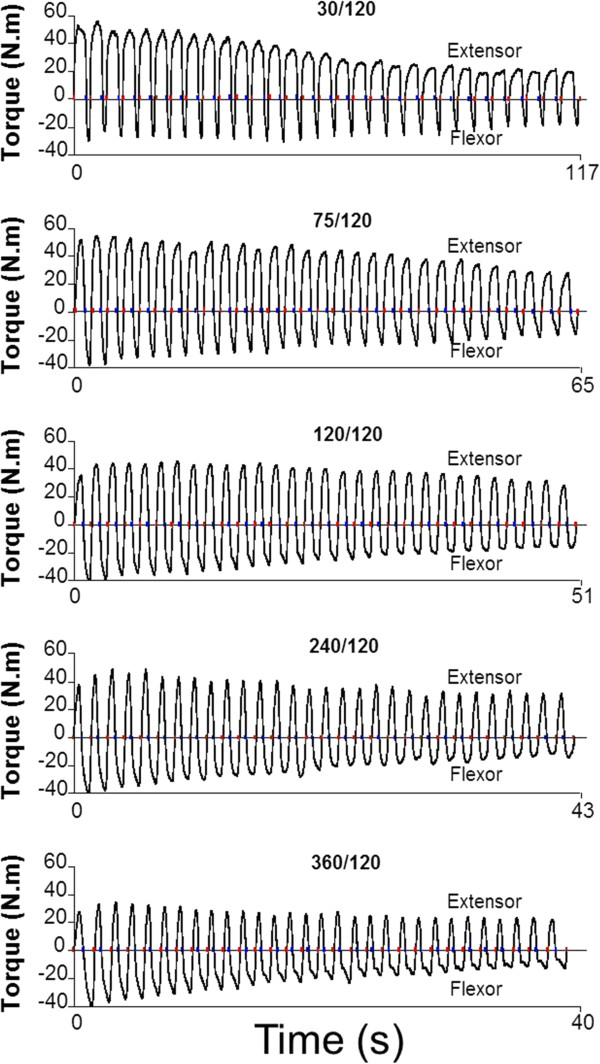
Aligned time series values of flexor and extensor elbow muscle torques in 5 different attempts (30, 75, 120, 240 and 360º/s) of one volunteer. The colored dots indicate the beginning and end of each movement.